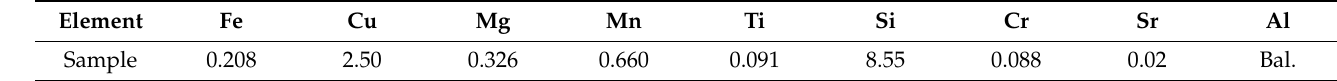
Figure 1. Photograph of a non-heat-treated, die-cast aluminum alloy sample. Table 1. The chemical composition of the die-cast sample (mass